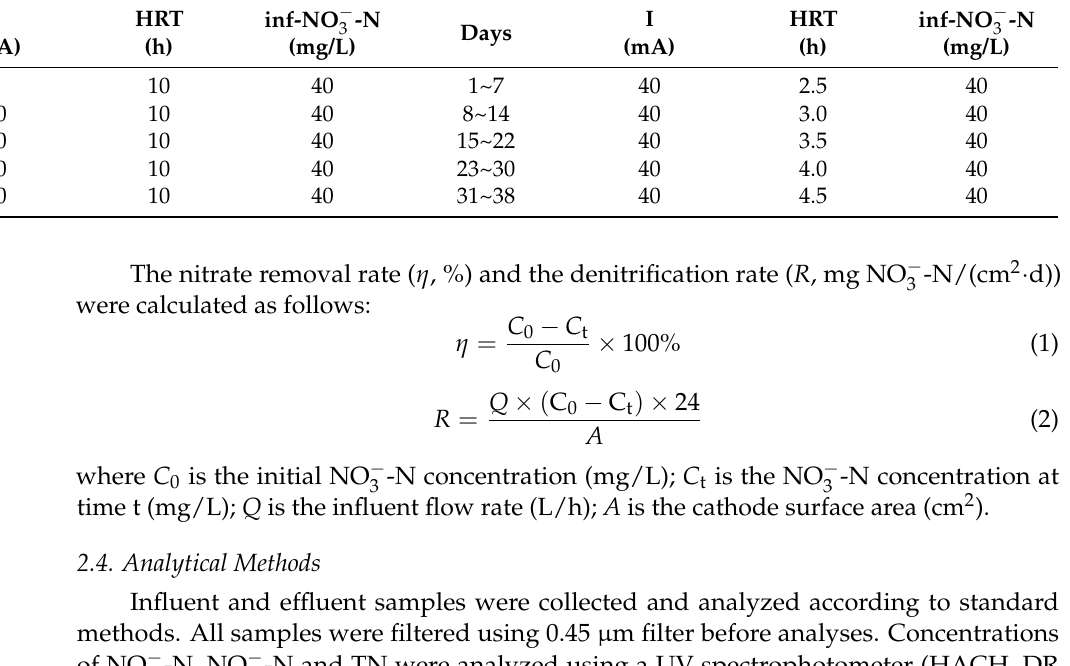
Table 1. Operation parameters of